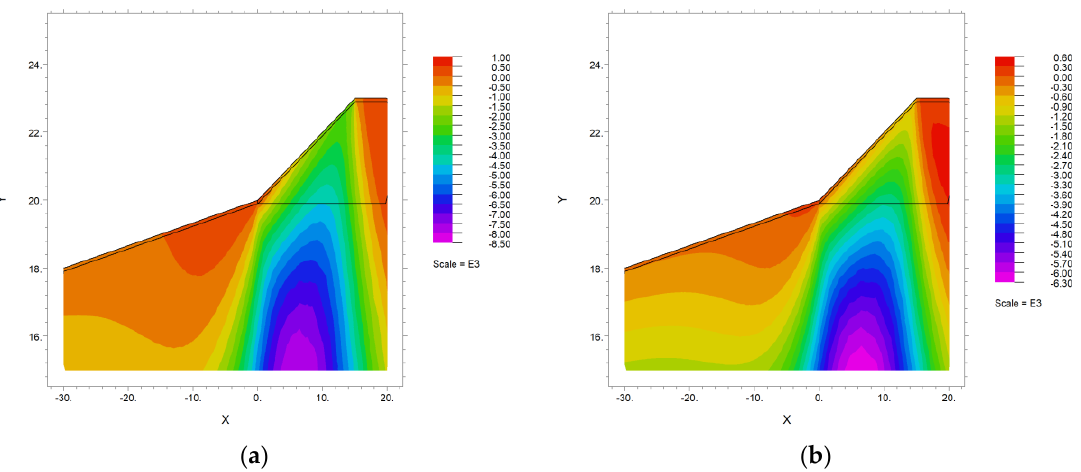
Figure 8. Shear stresses for the underwater slope inclination of 1:15: ( a ) clay-type subsoil, ( b ) sand- type subsoil (negative values indicate compressive stresses in Pa, positive values—tensile stresses in Pa).